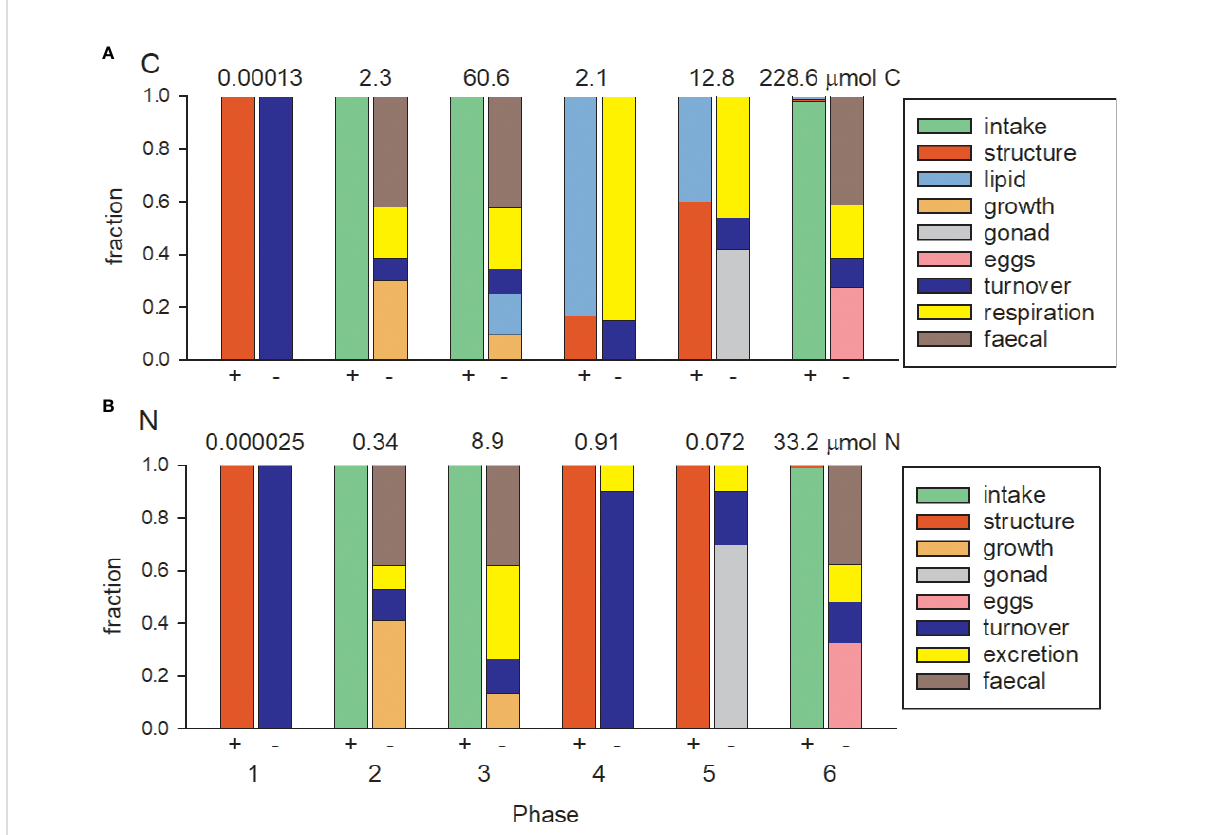
FIGURE 5 C and N budgets by Phase. The bars are normalised to total C and N fl uxes showing source (-) and sink (+) terms. Values for the total fl uxes, which balance for each Phase, are shown above each pair of bars. (A) carbon: intake, structural biomass, lipid, structural growth, biomass turnover (contributes to respiration), direct respiration of CO 2 , faecal, gonad and eggs; (B) nitrogen: intake, structural biomass, structural growth, biomass turnover (contributes to excretion), direct excretion, faecal, gonad and